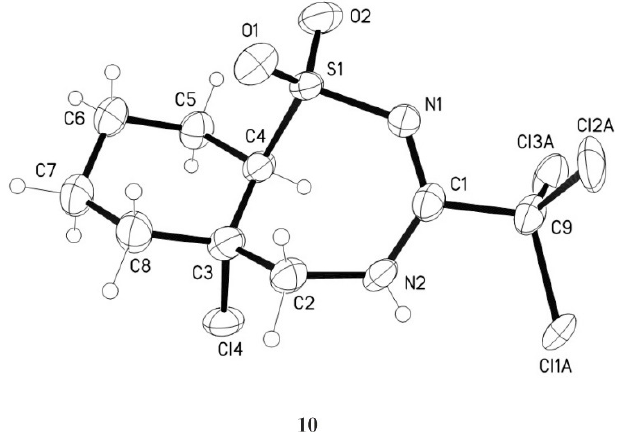
Figure 4. Molecular structure of 5a ‐ chloro ‐‐ 3 ‐ trichloromethyl ‐ 4,5,5a,6,7,8,9,9a ‐ octahydro ‐ 1,2,4 ‐ benzothiadiazepine ‐ 1,1 ‐ dioxide 10 including thermal displacement ellipses with 50% probability.